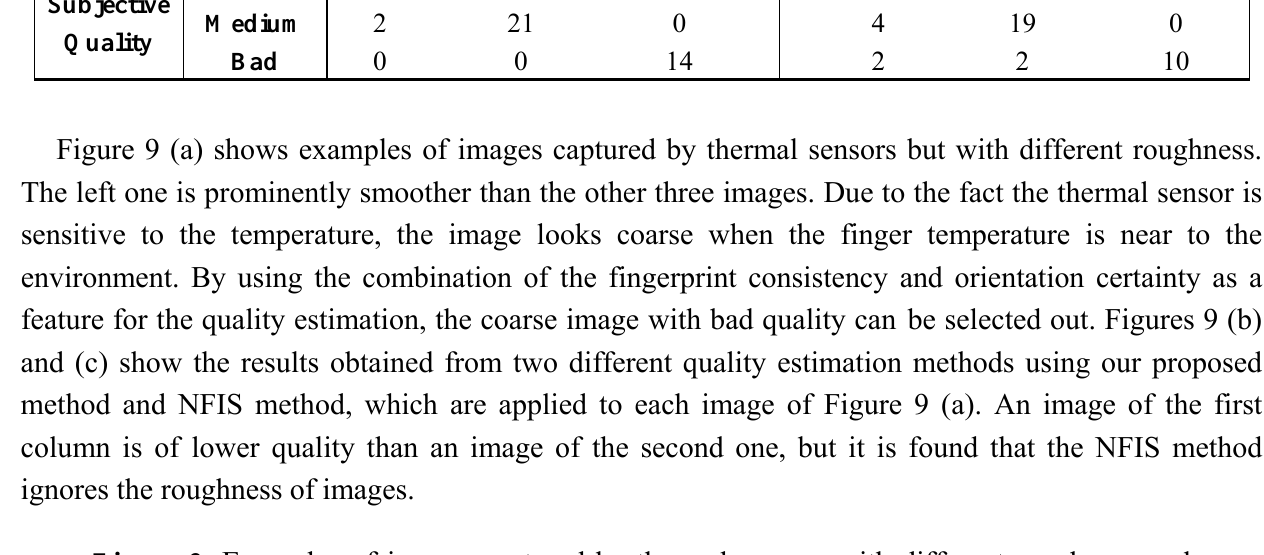
Figure 9. Examples of images captured by thermal sensors with different roughness and their results obtained from two different quality estimation